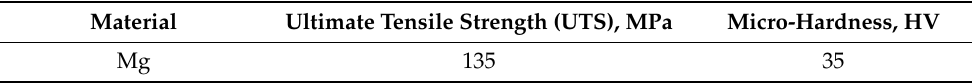
Table 1. Mechanical properties of the commercially pure Mg plates used for FSP.